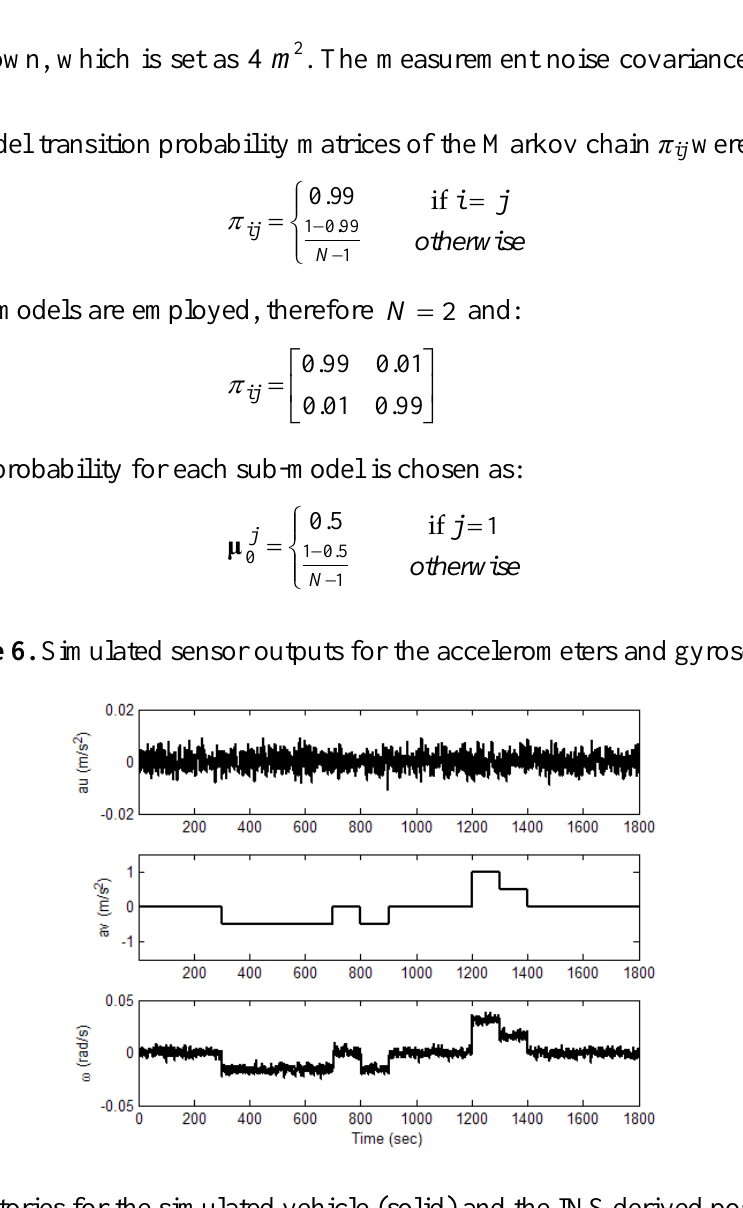
Figure 7. Trajectories for the simulated vehicle (solid) and the INS derived position